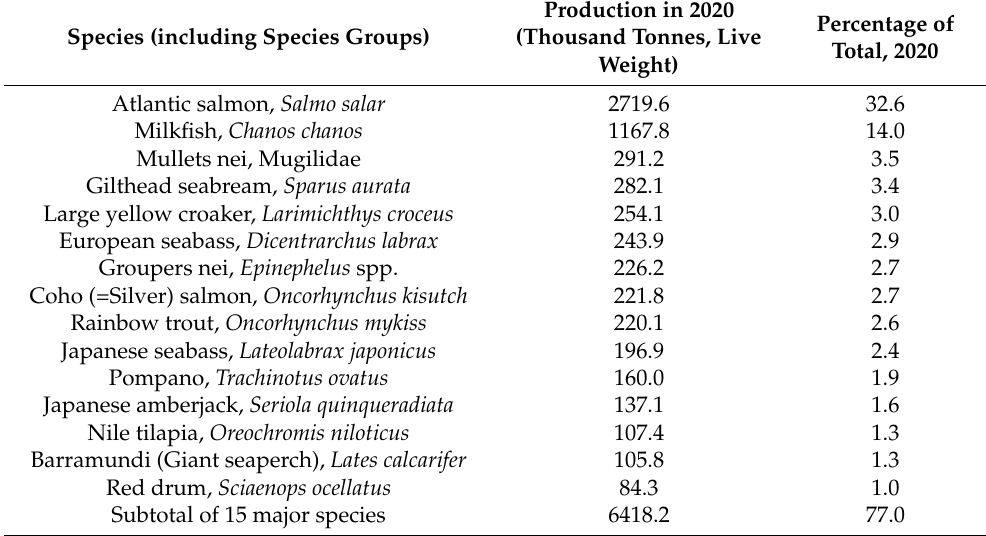
Table 3. Fifteen species (including the species group) most cultivated in marine and coastal aquacul- ture in the year 2020, with the percentage of the total produced worldwide, in the same year. Source: FAO [2].